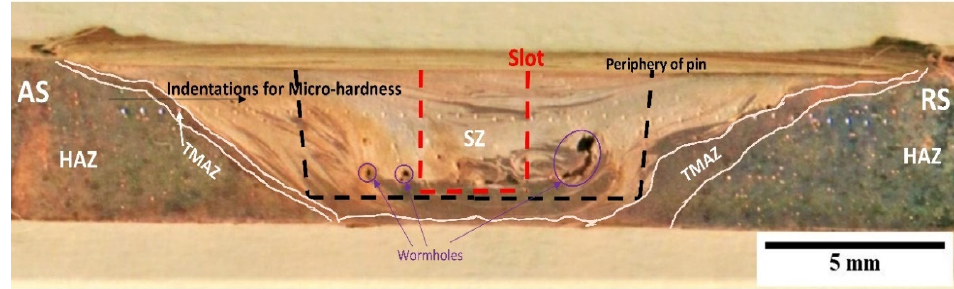
Figure 2. Macrostructure of the alloyed/processed region.